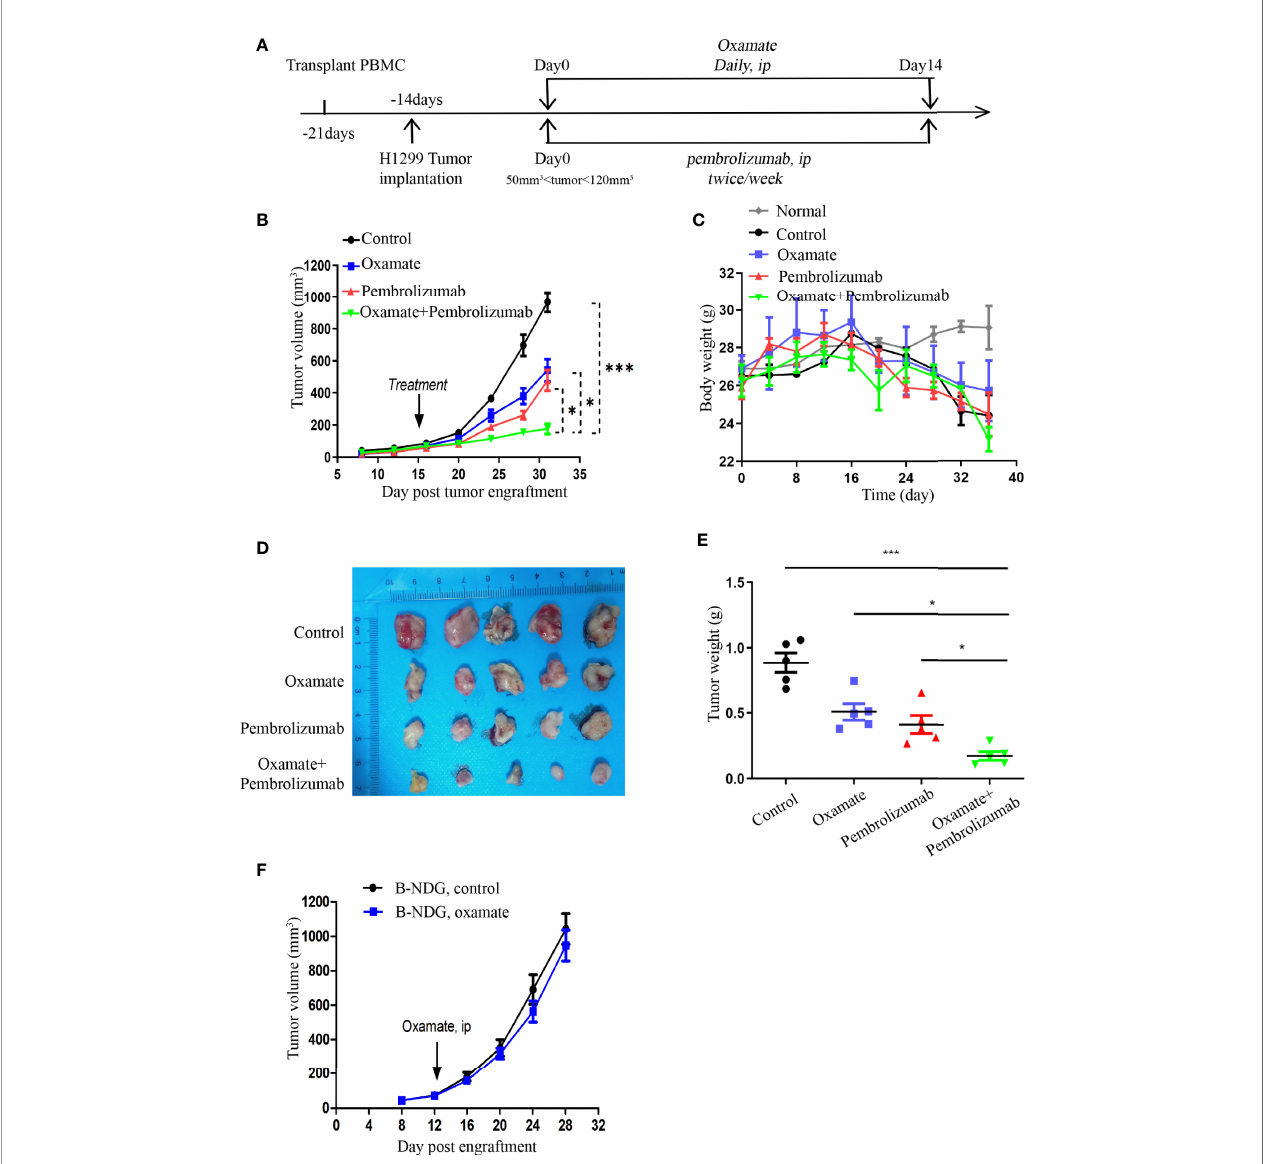
FIGURE 4 | Effects of Oxamate alone or in Combinations with Pembrolizumab on NSCLC Hu-PBMC-CDX. (A) Experimental timeline for treatment NSCLC CDX with Oxamate and pembrolizumab in Hu-PBMC-B-NDG mice. (B) Tumor growth curve of control group, Oxamate monotherapy group, Pembrolizumab monotherapy group and combination treatment group. Data are presented as the mean ± SD of the volume of CDX (mm 3 ); n = 5. *P<0.05, ***P<0.001. (C) The body weight of mice in each treatment group and normal mice without PBMCs transplantation was monitored every four days from the beginning of PBMCs transplantation to the end of treatment; n=5. (D, E) At the end of treatment, the tumors of each treatment group were collected, photographed and weighed; n = 5. *P<0.05, ***P<0.001 (F) Tumour growth after treated with Oxamate or PBS in B-NDG mice bearing NSCLC cell line. Group mean differences between Oxamate vs. controls were not signi fi cant; n =